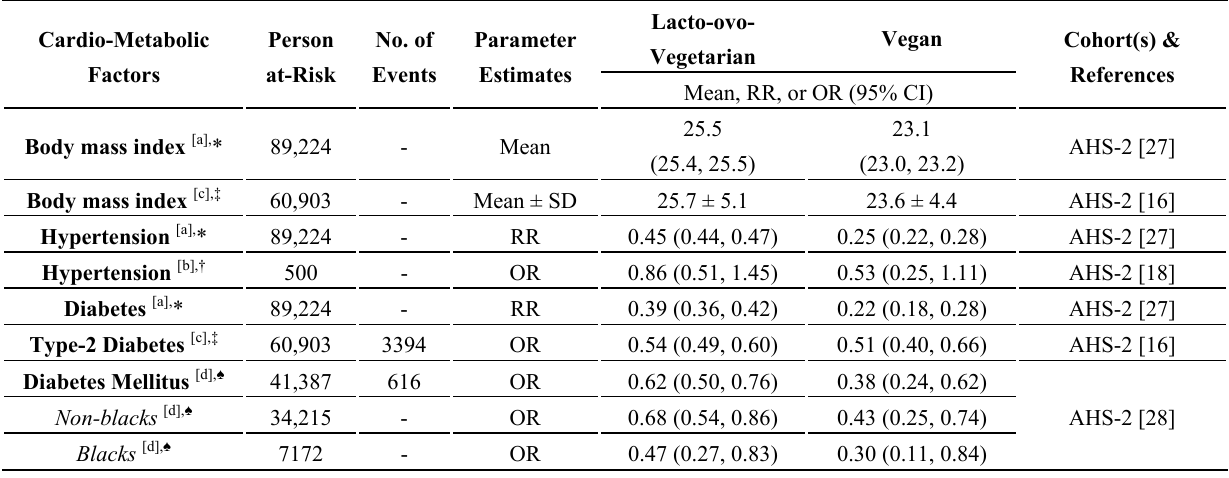
Table 6. Cardiometabolic-related factors among vegan and lacto-ovo-vegetarian Adventists. Cardio-Metabolic